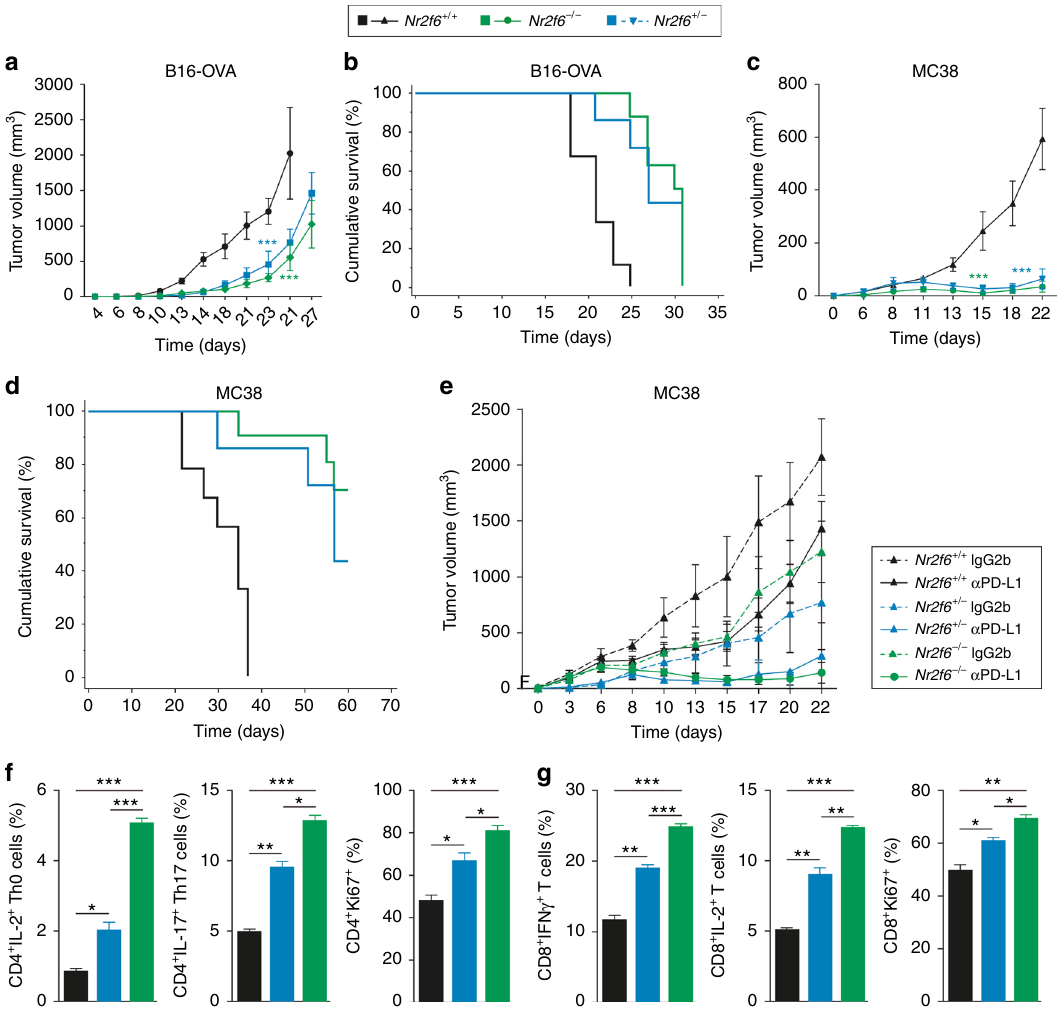
Fig. 4 Heterozygous Nr2f6 + / − mice similarly show strong tumor growth bene fi t. Tumor growth curves of Nr2f6 + / + , Nr2f6 + / − and Nr2f6 − / − mice that received a 1×10 5 B16-OVA melanoma cells ( Nr2f6 + / + ( n = 21), Nr2f6 + / − ( n = 11), and Nr2f6 − / − ( n = 21)) or c 5×10 4 MC38 tumor cells ( Nr2f6 + / + ( n = 16), Nr2f6 + / − ( n = 5), and Nr2f6 − / − ( n = 10)) subcutaneously and were monitored three times a week showing a signi fi cant tumor growth delay as well as a survival bene fi t ( b - d ) in Nr2f6 gene-modulated mice ( p <0.0001 for both tumor cell lines, ANOVA). e Tumor growth curves of Nr2f6 + / + (IgG2b n = 5, α PD-L1 n = 10) , Nr2f6 − / − (IgG2b n = 7, α PD-L1 n = 12) and Nr2f6 + / − (IgG2b n = 3, α PD-L1 n = 3) mice injected s.c. with 5×10 5 B16-OVA melanoma cells and treated with PD-L1 blockade (continuous line) or IgG2b (dashed line) ( n = 3 – 5). Both α PD-L1 treated Nr2f6 + / − ( p = 0.0179, ANOVA) and Nr2f6 − / − ( p < 0.0001, ANOVA) showed a signi fi cant slower tumor growth when compared to treated wild-type controls. f , g In vitro fl ow cytometry analysis of isolated CD4 + or CD8 + T cells activated with anti-CD3 mAb (5 µ g) and anti-CD28 mAb (1 µ g) at d3 from Nr2f6 + / + , Nr2f6 + / − or Nr2f6 − / − mice ( n = 3). Analysis of IL-2 and IL-17-producing CD4 + Th0 and Th17 T cells, Ki67 + proliferating CD4 + and CD8 + T cells, and IFN γ as well as IL-2 production of CD8 + T cells. Percentage of positive cells relative to parental gate is shown; experiments were repeated at least three times. Results shown are derived from at least two independent experiments. Error bars represent the mean ±